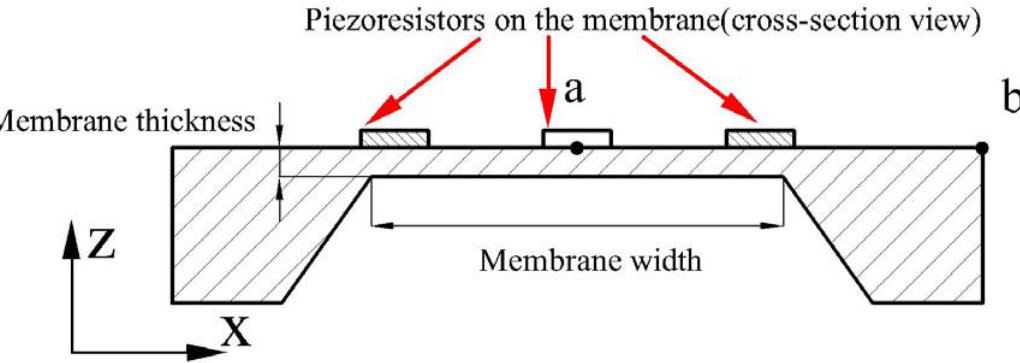
Figure 1. Conceptual design model of the proposed micro pressure